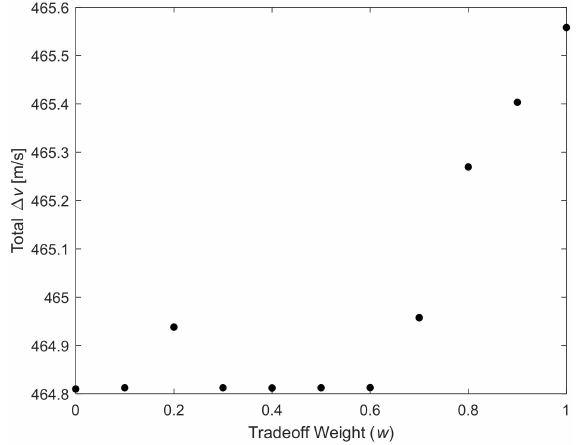
Figure 6. Fuel consumption vs. tradeoff weight.